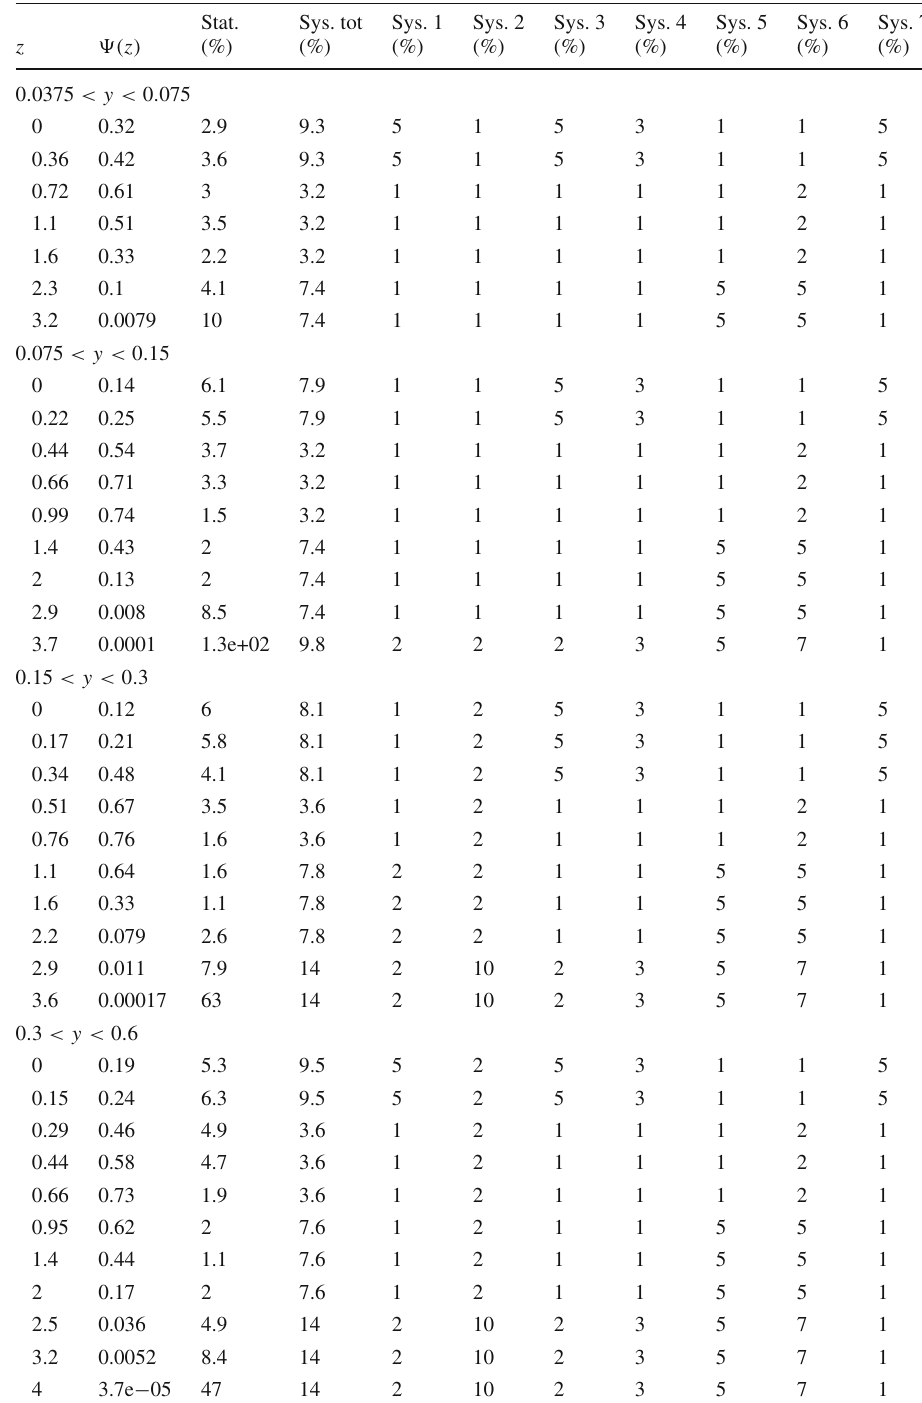
KNO function of multiplicity distributions in